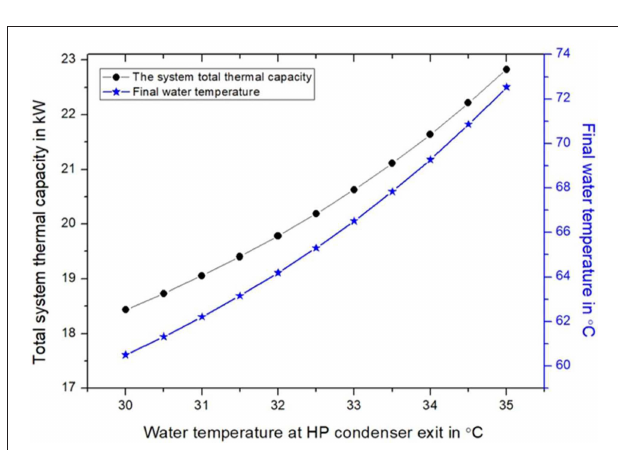
FIGURE 6 | Total system heating capacity and final water temperature under when T w − exit − HP varies.